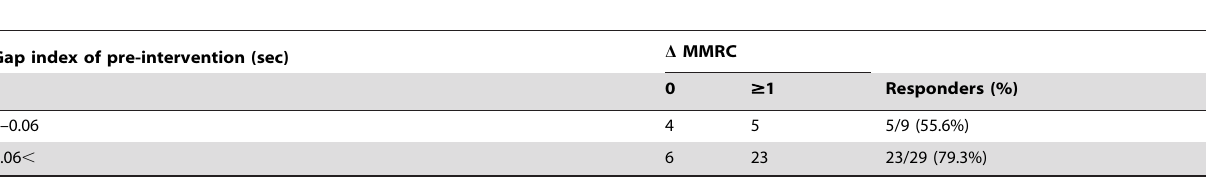
Table 5. Relation between the baseline of the degree of gap index and the change in MMRC scale after interventional bronchoscopy in cases with bronchial involvement.